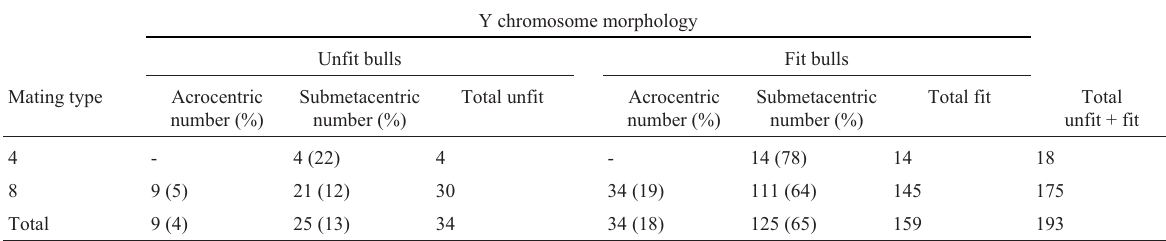
Table 4 - Genealogically determined frequency of the different Y chromosome morphological types found in reproductively fit and unfit Brangus-Ibagé bulls. Y chromosome